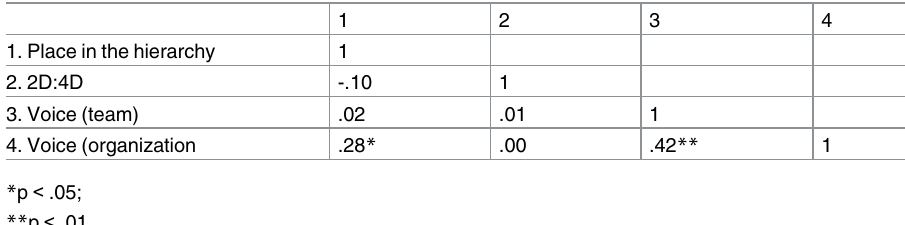
Table 1. Correlations between the main variables of interest.